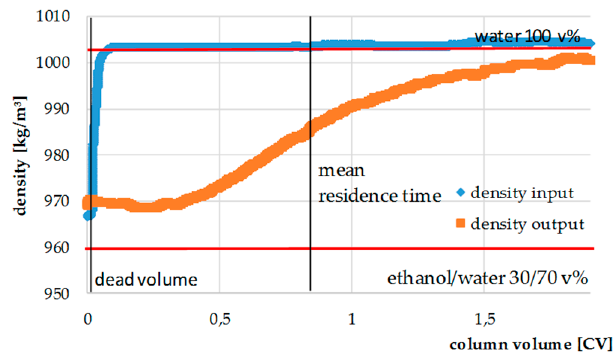
Figure 12. Residence time distribution with column and packing.